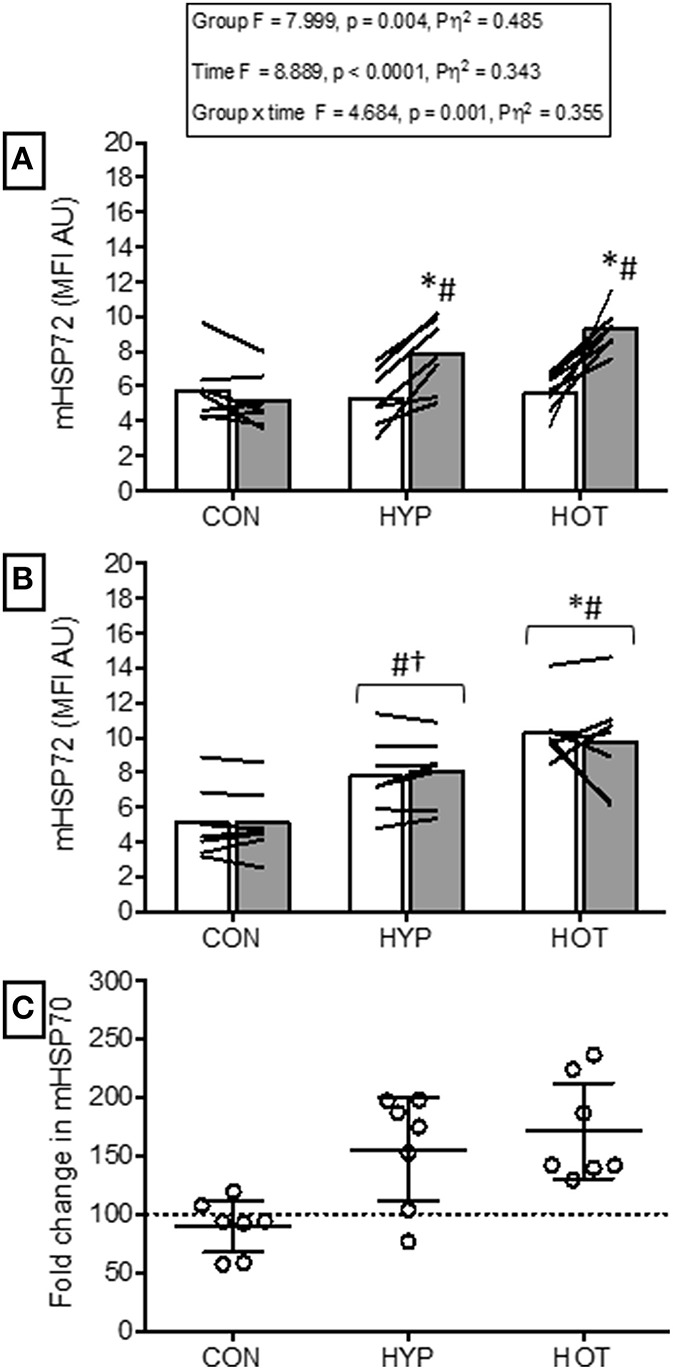
Monocyte HSP72 responses before and after the acclimation period. (A) mHSP72 is increased post exercise on day 1 of HYP and HOT, but not CON. (B) Resting mHSP72 was unchanged in CON and increased in HYP and HOT on day 10 of acclimation compared to day 1 of acclimation. Subsequently, the post exercise mHSP72 response in HYP and HOT was attenuated compared to post exercise on day 1. (C) The magnitude of change in resting mHSP72 on day 10 of acclimation was no different between HYP and HOT (C). Open bars and shaded bars represent pre and post exercise, respectively. Lines (A, B) and dots (C) represent individual participant responses (n = 21) and bars show the mean group response. The dashed line (C) represents baseline mHSP72. *Different from day 1 pre-exercise (p < 0.01). #Different from control (p < 0.01). †Different from control (p < 0.05).